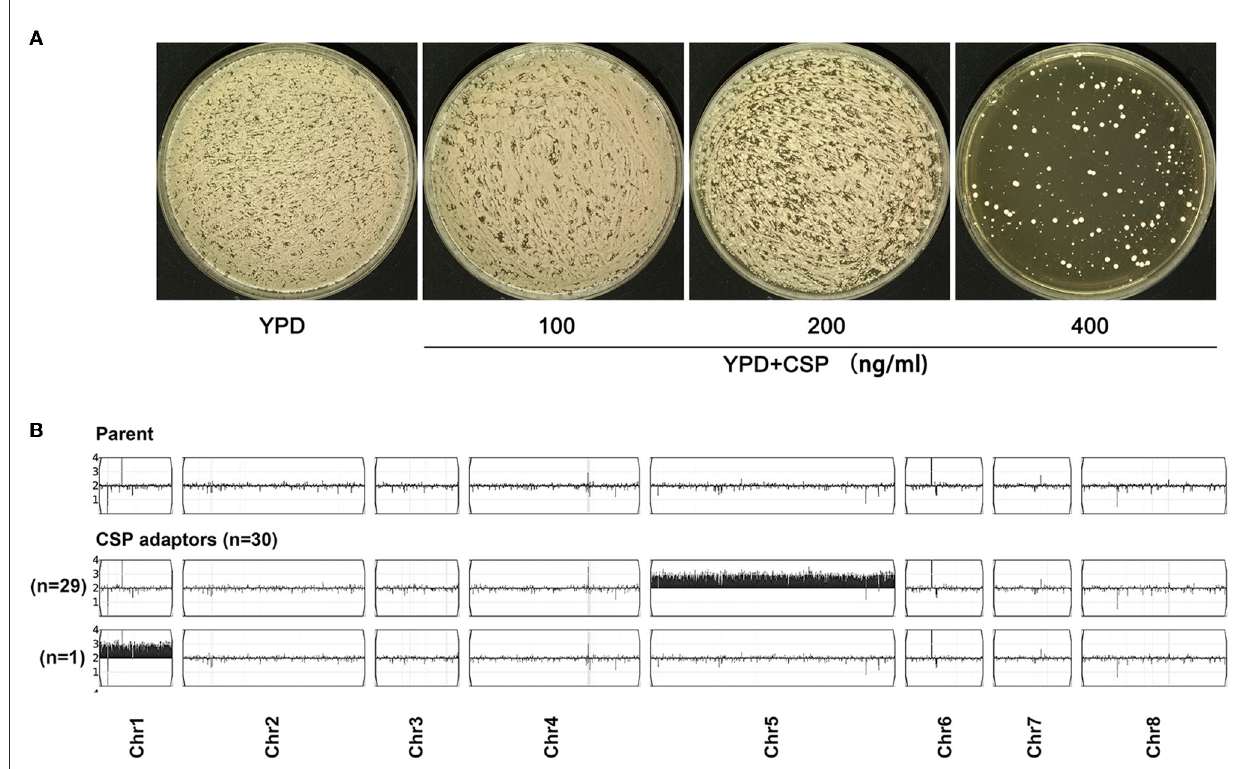
FIGURE1 In C. parapsilosis , caspofungin adaptors are aneuploid. Approximately 1 million cells of C. parapsilosis strain #12108 were spread on YPD plates with or without caspofungin (CSP). The plates were incubated at 37 ◦ C for 5 days (A) . On the plate with 400ng/ml of CSP, randomly 30 adaptors were chosen and sequenced. The karyotypes were visualized using Ymap (B) . Read depth (normalized to that of the diploid parent) is shown on the y-axis on a log 2 scale converted to absolute copy numbers (1–4). The number of adaptors bearing the same aneuploidy was also shown in the